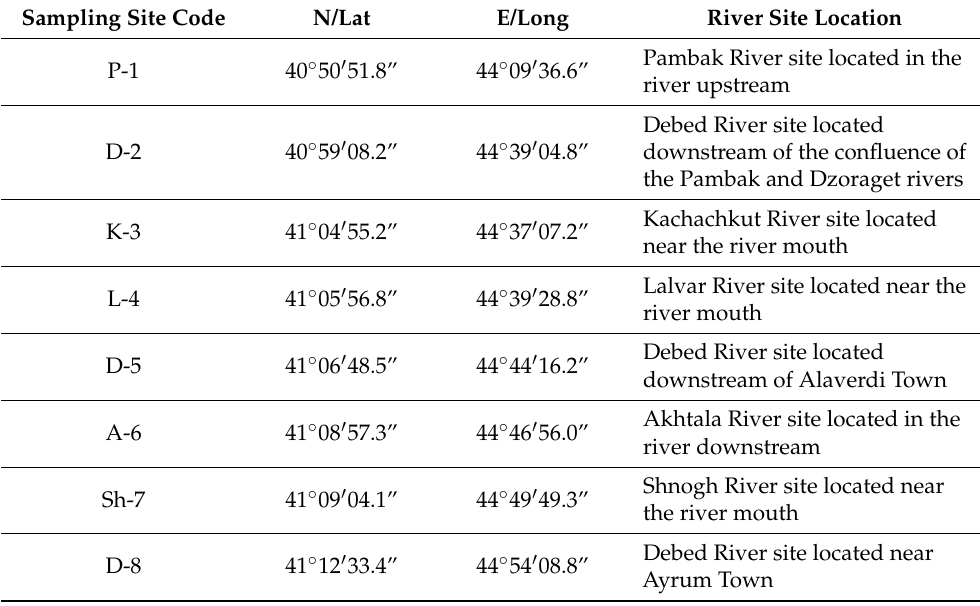
Table 1. Coordinates of sampling sites in the Debed River catchment